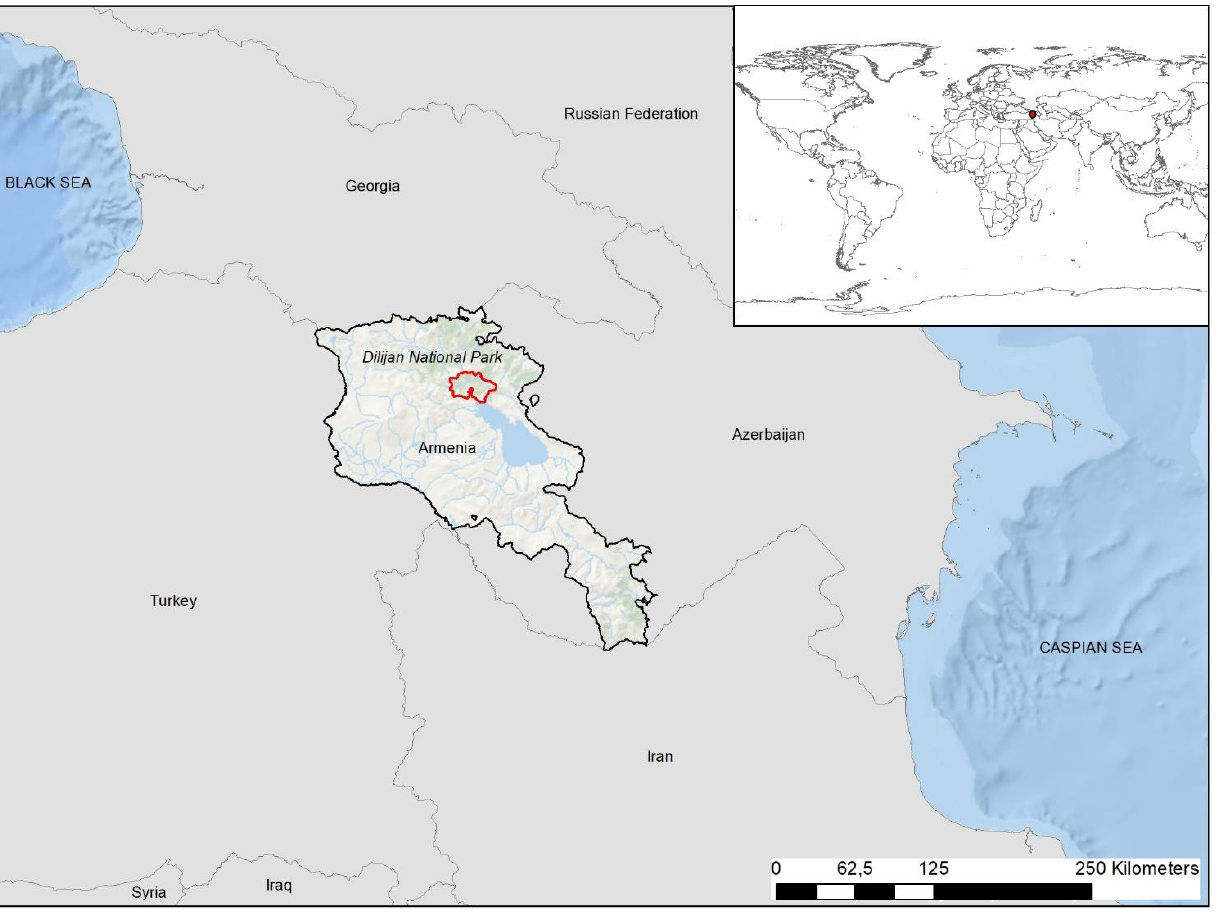
Figure 1. Study area: Dilijan National Park, Armenia © OpenStreetMap (2021), ESRI World Oceans.